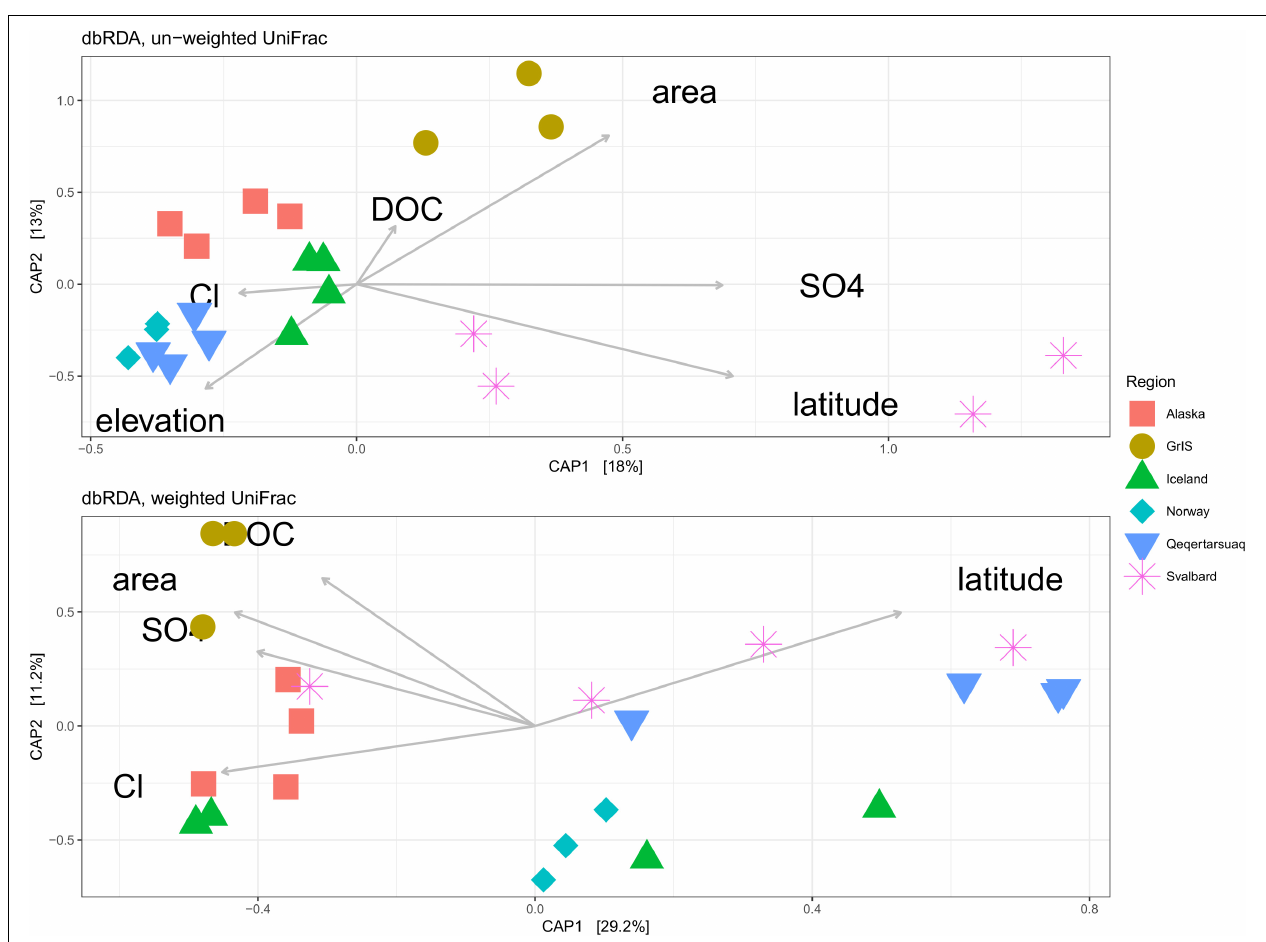
FIGURE 6 | Distance-based redundancy analysis (dbRDA) showing the most parsimonious combination of explanatory variables for explaining assemblage structure for both un-weighted (top) and weighted (bottom) UniFrac datasets. Sites with missing metadata were excluded (i.e., Foxfonna and Midtre Lovénbreen, see Tables 1 , 2 ). Alaska sites are shown in red squares, the Greenland Ice Sheet (GrIS) in gold circles, Iceland in green triangles, Norway in turquoise diamonds, Qeqertarsuaq in blue upside-down triangles, and Svalbard in purple